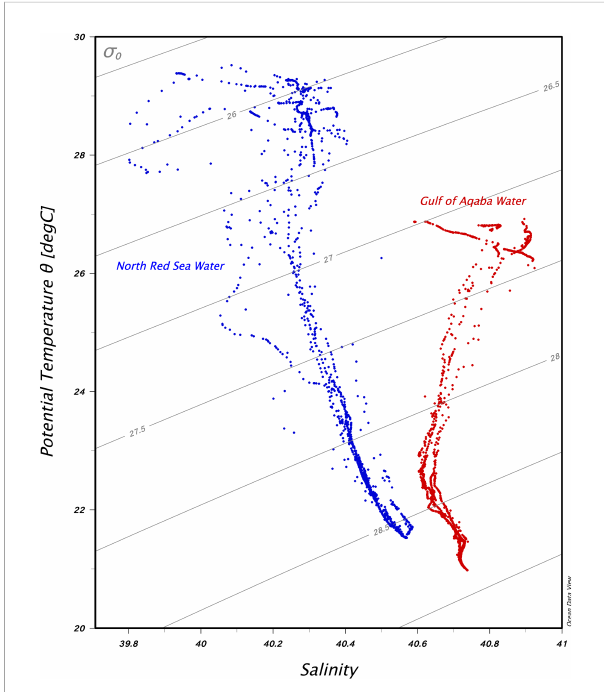
FIGURE 3 Temperature – salinity diagram with isopycnal contours in the water column of the Gulf of Aqaba stations (red dots) and the northern Red Sea stations (blue